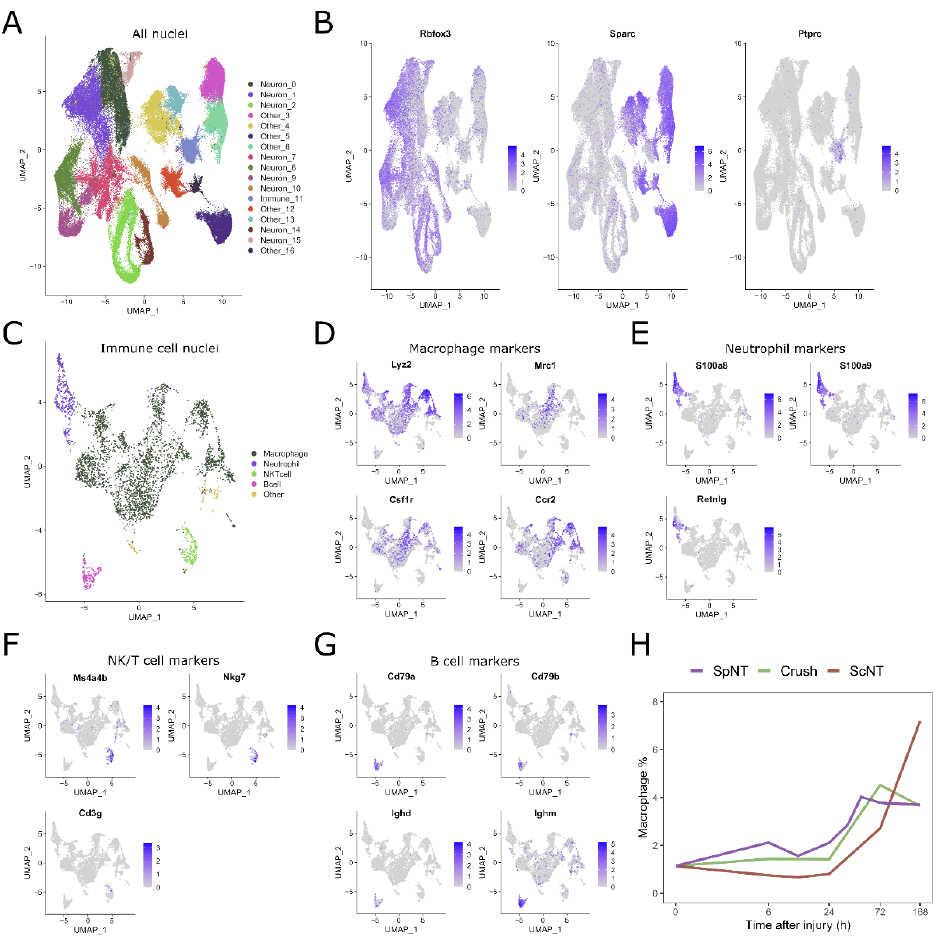
Figure 1. Single-nucleus transcriptomics show a proportional increase in the number of macrophages in the mouse DRG after PNI. ( A ) UMAP dimensional reduction plot showing the clustering of all cell types. Clusters 0 to 16 are annotated as neurons, immune cells, or other. ( B ) The expression of marker genes used for the annotation of neurons ( Rbfox3 ), other cell types ( Sparc ) and immune cells ( Ptprc ). ( C ) Nuclei from the Immune_11 cluster were re-clustered to obtain clusters for different immune cell subtypes. ( D ) Macrophage marker genes ( Lyz2, Mrc1, Csf1r, and Ccr2 ). ( E ) Neutrophil marker genes ( S100a8, S100a9, and Retnlg ). ( F ) NK/T cell marker genes ( Ms4a4b, Nkg7, and Cd3g ). ( G ) B cell marker genes ( Cd79a, Cd79b, Ighd, and Ighm ). ( H ) Percent of macrophage nuclei from the total nuclei at different time points after PNI. The scale of the x-axis is transformed to log2. The gradient color in ( B ) and ( D – G ) represents the level of the normalized gene expression in individual nuclei. Abbreviations: spinal nerve transection (SpNT); sciatic nerve crush (Crush); sciatic nerve transection (ScNT).